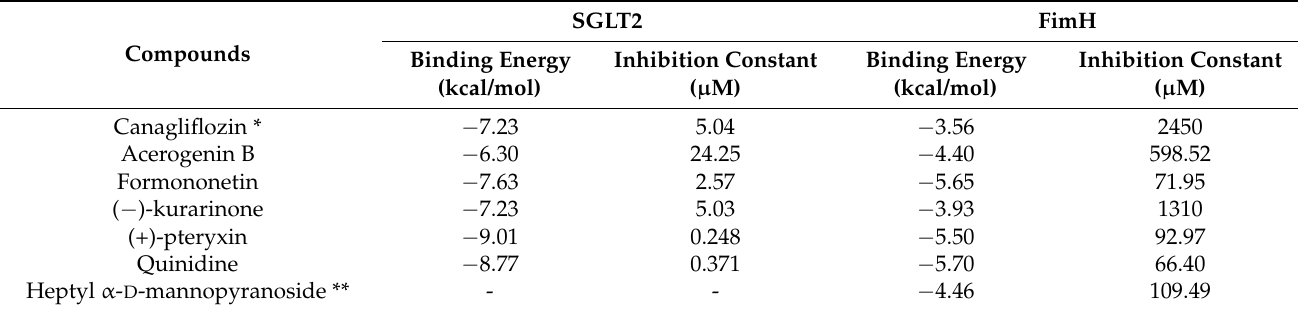
Figure 2. The amino acid residue of SGLT2 interacting with formononetin ( a ), (+)-pteryxin ( b ), quinidine ( c ), and canagliflozin ( d ). The ligands (formononetin, (+)-pteryxin, quinidine, and canagliflozin) are represented as green stick forms and hydrogen bonds are indicated as green dashed lines. Table 3. The docking results of the molecular interactions of SGLT2 and FimH with natural SGLT2 inhibitors and control